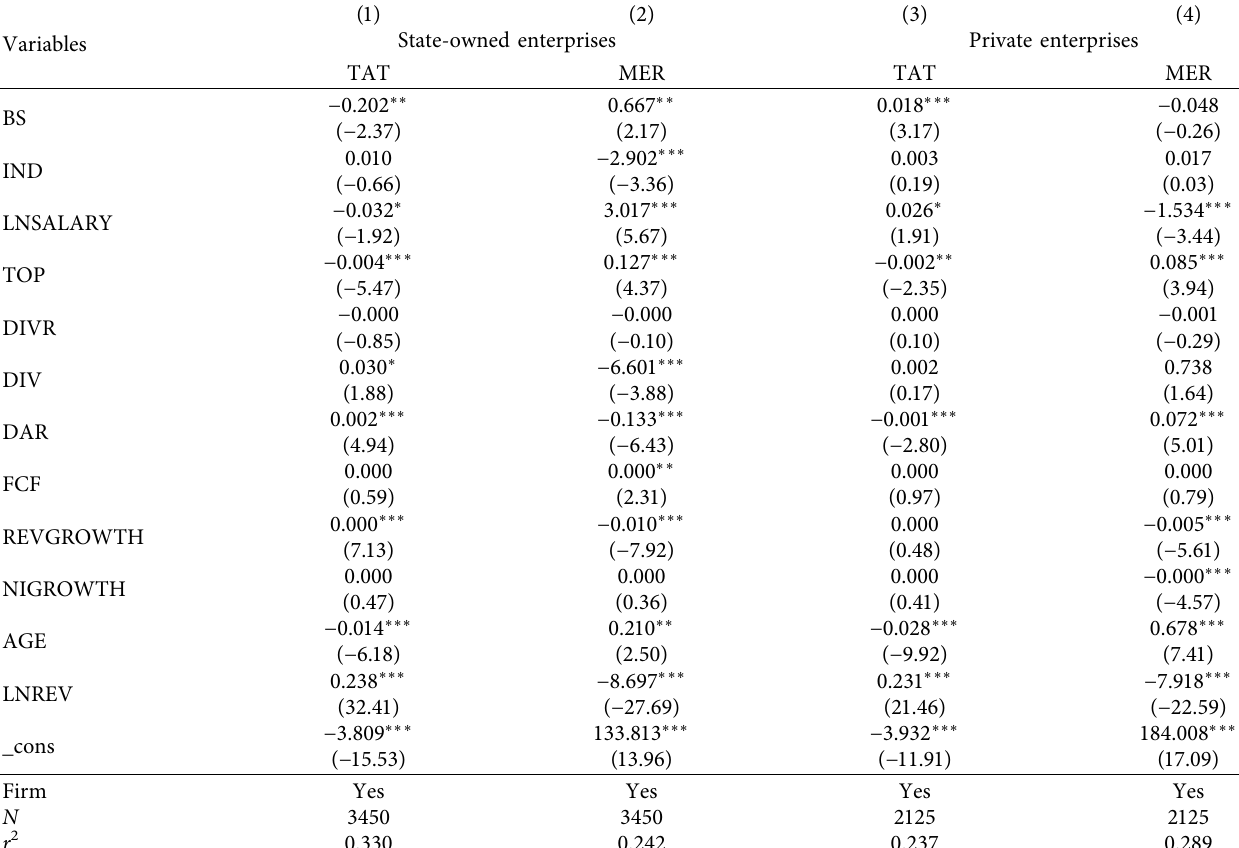
Table 5: Panel OLS regression of the effect of corporate governance on agency cost.